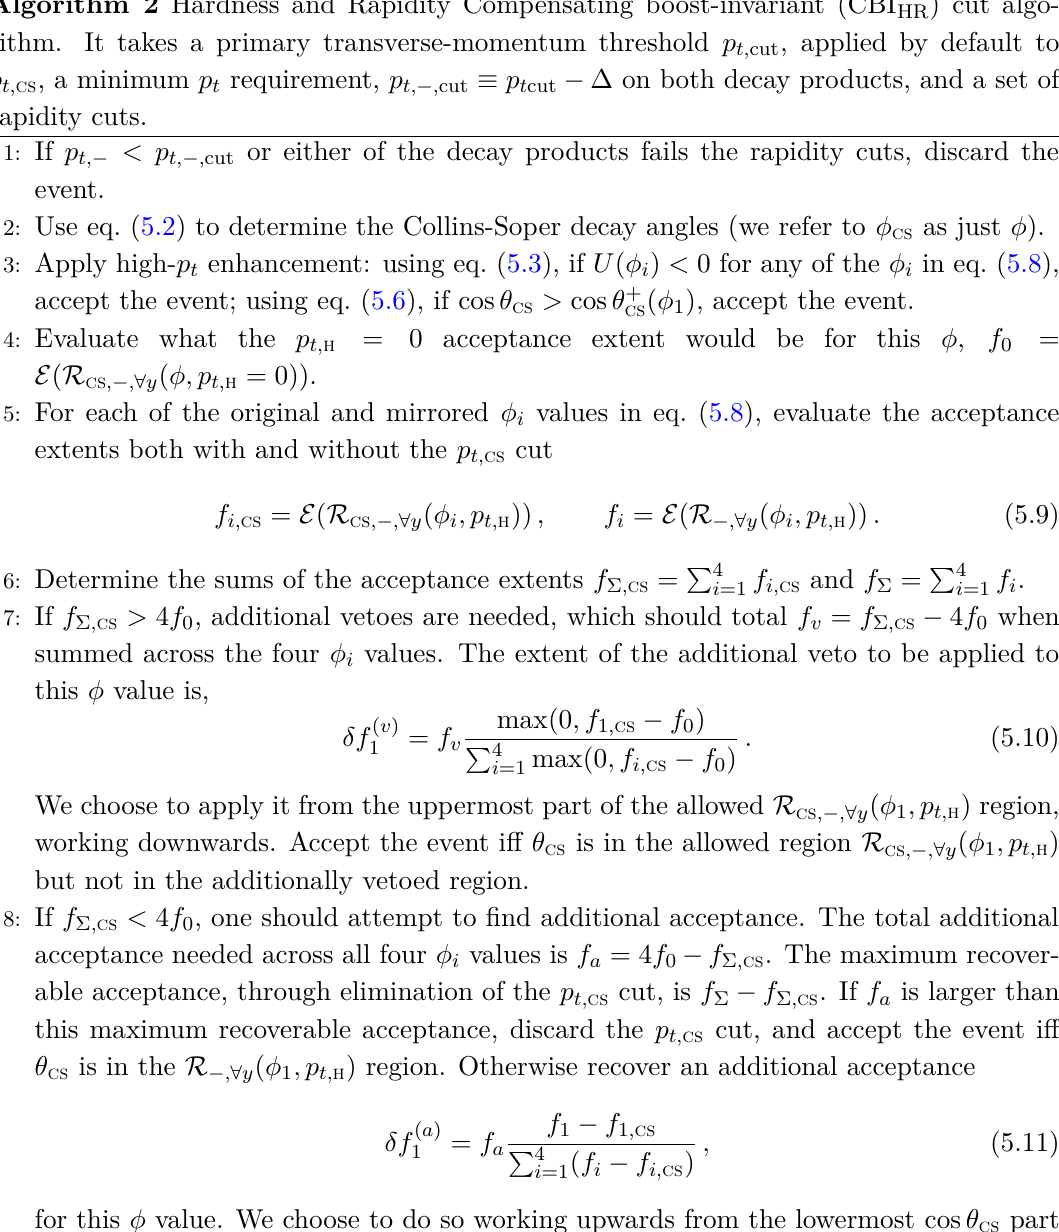
Algorithm 2 Hardness and Rapidity Compensating boost-invariant (CBI ) cut algo- HR rithm. It takes a primary transverse-momentum threshold p , applied by default to t, cut p , a minimum p requirement, p ≡ p − ∆ on both decay products, and a set of t, cs t t, − , cut t cut rapidity